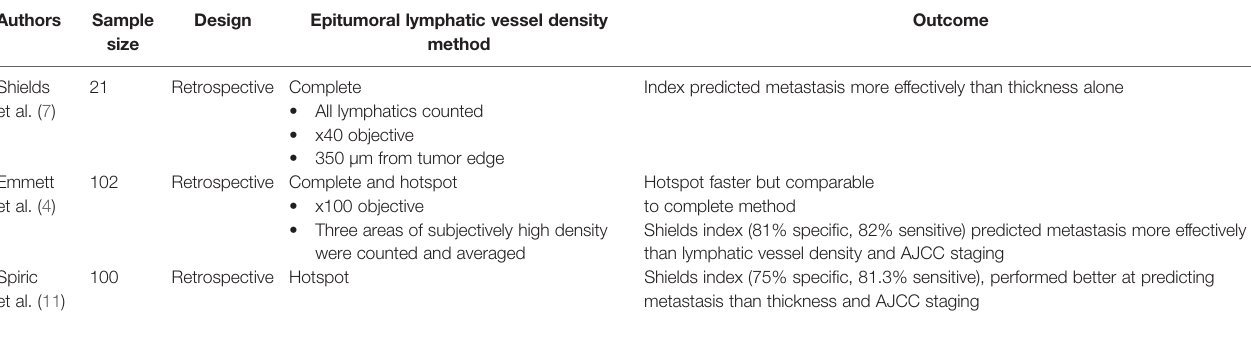
TABLE 1 | The Shields index to predict metastatic potential of cutaneous